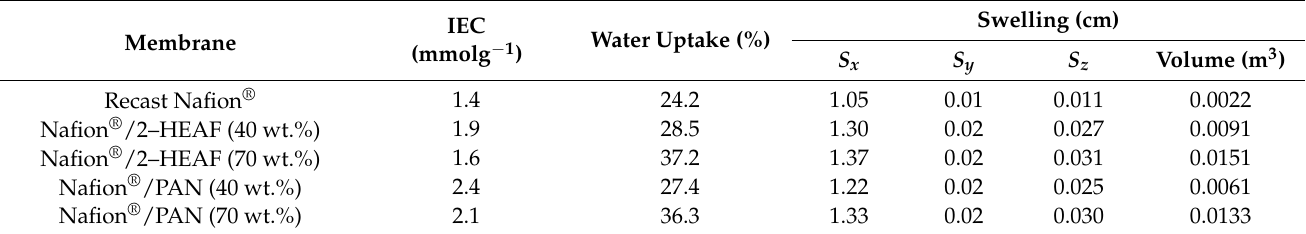
Table 2. Summarized result of IEC, water uptake and swelling analysis for all membrane.